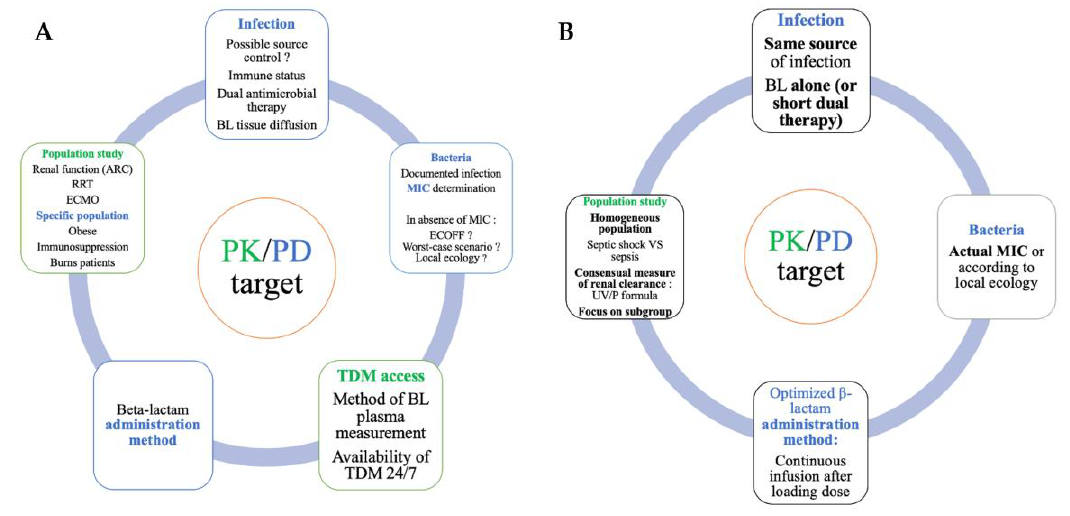
Figure 2. Keypoints to consider when constructing future studies on PK/PD target attainment (( A ), upper panel) and suggested five tips (( B ), lower panel). ARC: augmented renal clearance, RRT: renal replacement therapy, ECMO: extracorporeal membrane oxygenation, BL: beta-lactam, MIC: minimal inhibitory concentration, TDM: therapeutic drug monitoring, PK/PD: pharmacokinet-